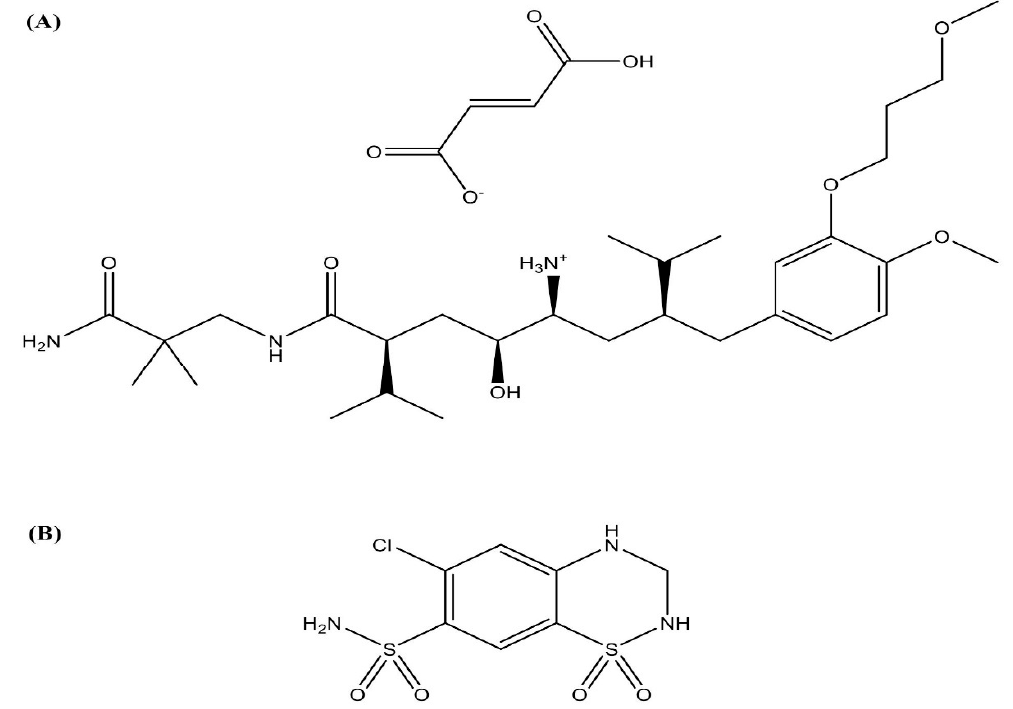
Figure 1. Chemical structures of ( A ) aliskiren hemifumarate and ( B ) hydrochlorothiazide (IS).